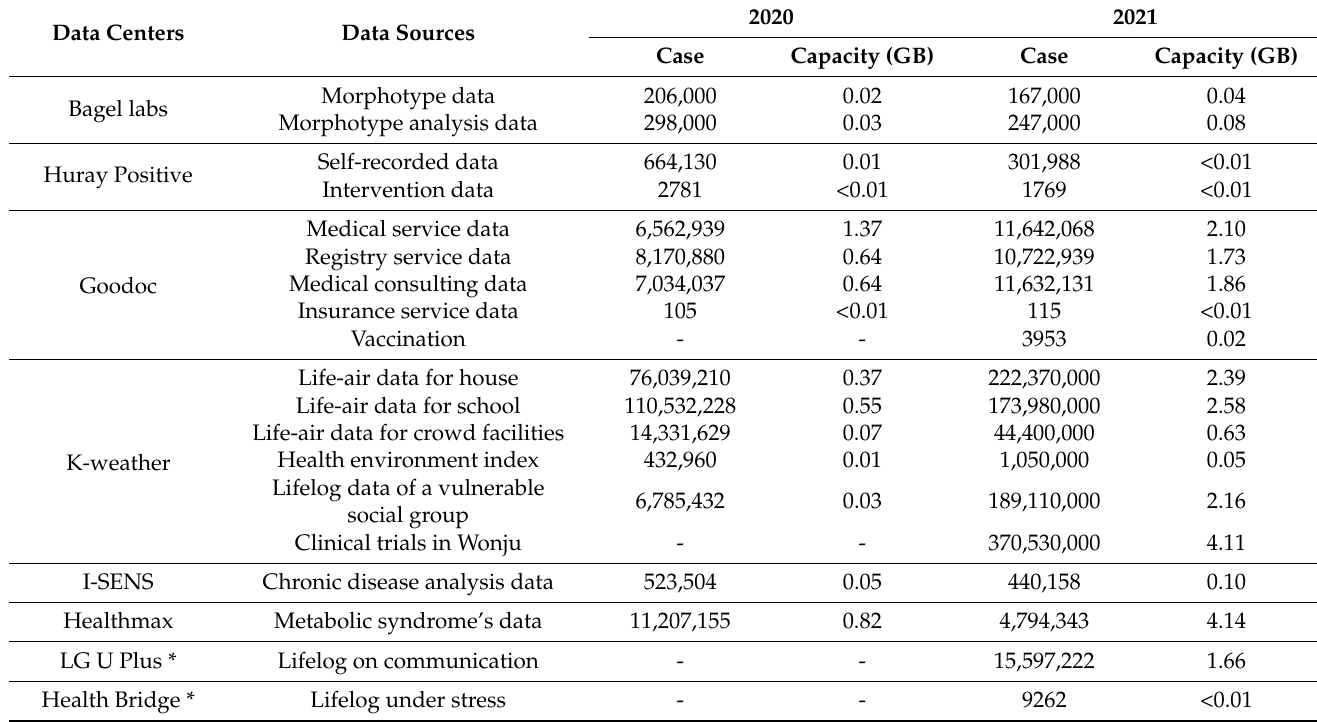
Table 3. The dataset list of lifelog data